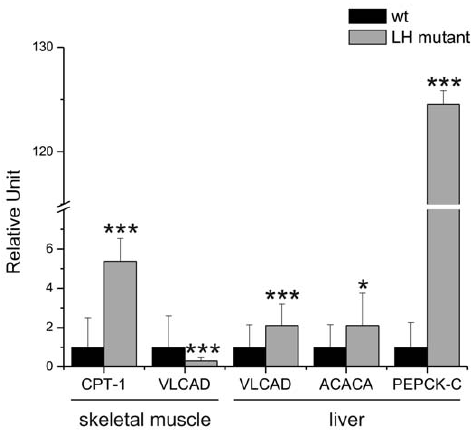
Figure 5. The expression of genes involved in b -oxidation, fatty acid synthesis and gluconeogenesis in LH mutant mice. Quantitative RT-PCR was used to determine changes in the gene expressions in LH mutant mice after 4 months of high fat diet. The columns represent the relative expression levels of muscular genes involved in the mitochondrial b -oxidation; CPT-1 and VLCAD and hepatic genes involved in the mitochondrial b -oxidation, fatty acid synthesis and gluconeogenesis; VLCAD, ACACA and PEPCK-C, respec- tively. For relative quantification of gene expression, the results were normalized using GADPH and b -actin as endogenous controls, and the expression of the wild type samples were set to 1. Results represent means with 95% confidence interval of 10 independently analyzed mice for each genotype. P values were calculated using unpaired hetero- scedastic student t-test with one-tailed distribution. * p , 0.05, ** p , 0.01, *** p , 0.001. Abbreviations: CPT-1=carnitine palmitoyltrans- ferase, VLCAD=very long chain acyl-CoA dehydrogenase,